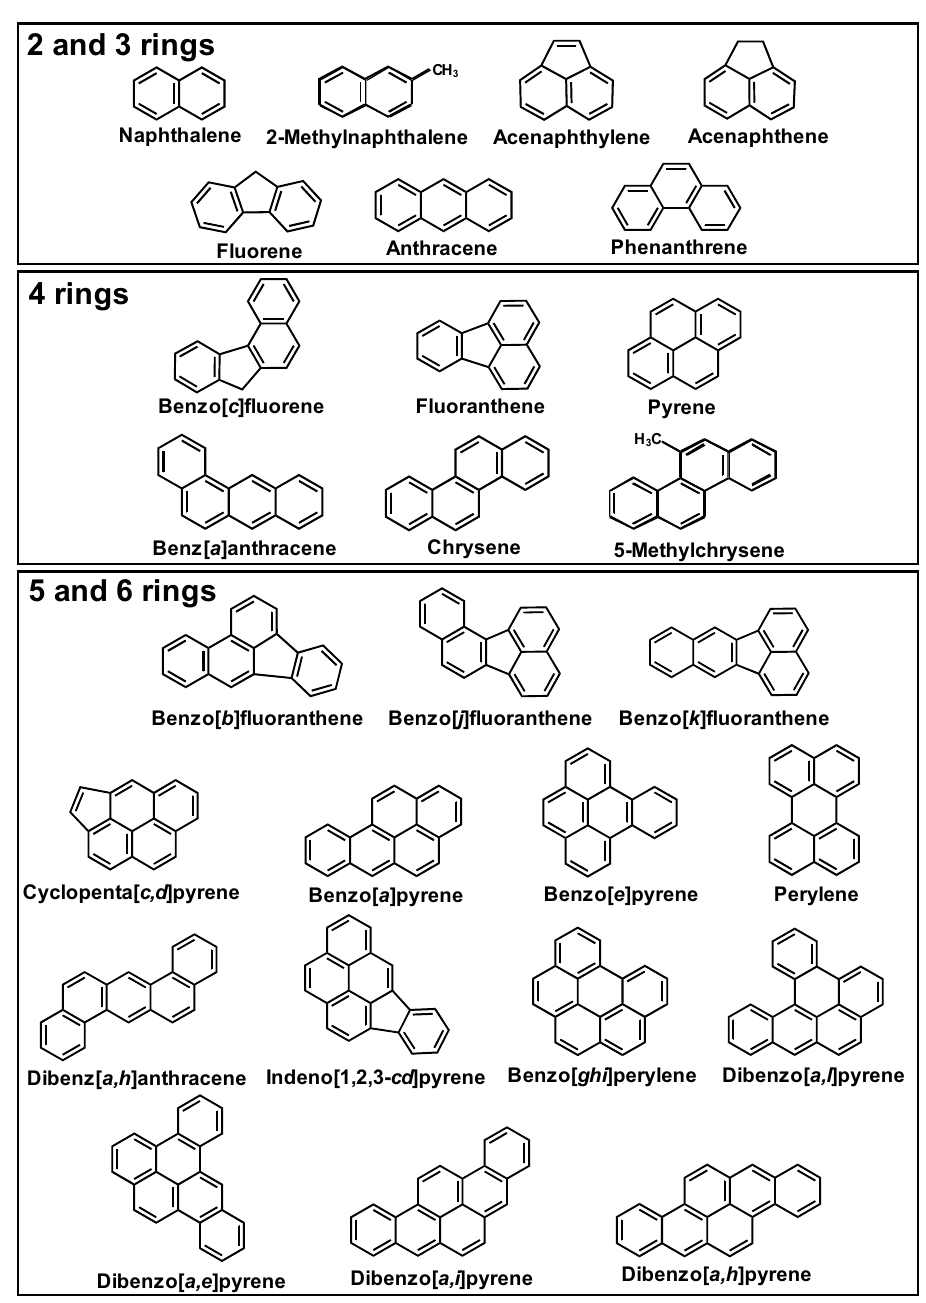
Figure 1. The chemical structures of the LMW (2 and 3 rings)-, MMW (4 rings)-, and HMW (5 and 6 rings)-